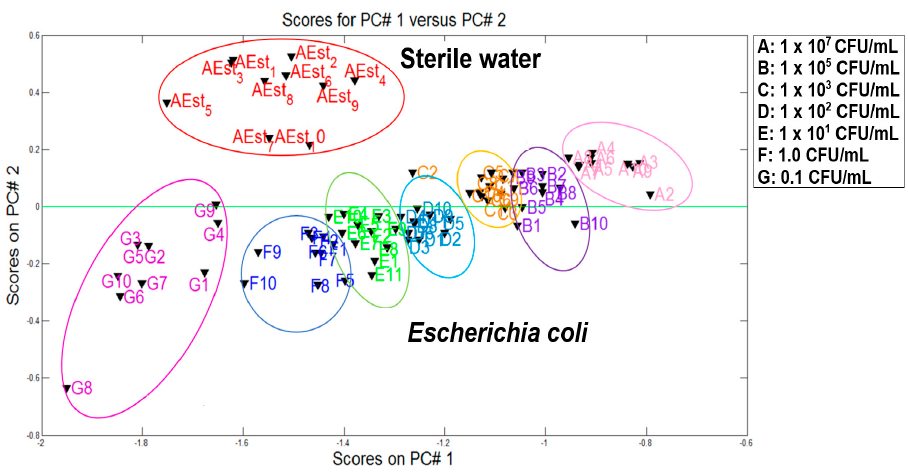
Figure 5. PCA plot of sterile water and di ff erent concentrations of E. coli .